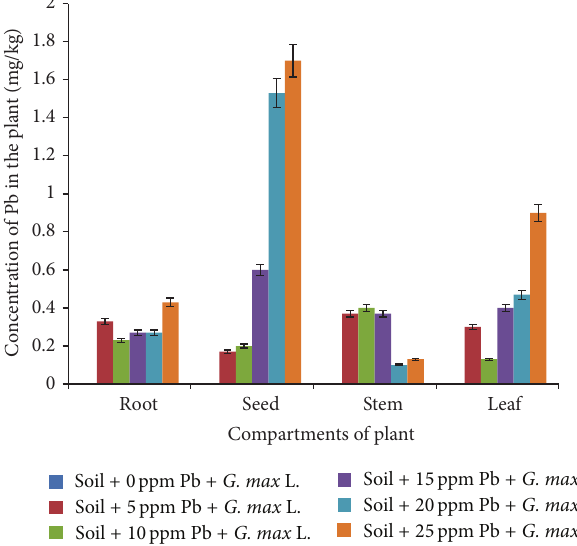
Figure 2: Available Pb in root, seed, stem,had and leaf of G. max